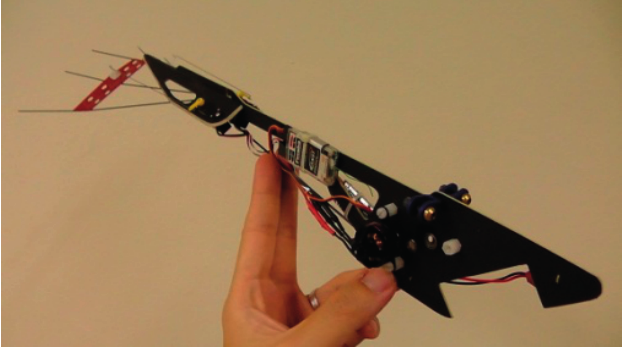
Figure 4. Near-resonance ornithopter-like flapping wing model.